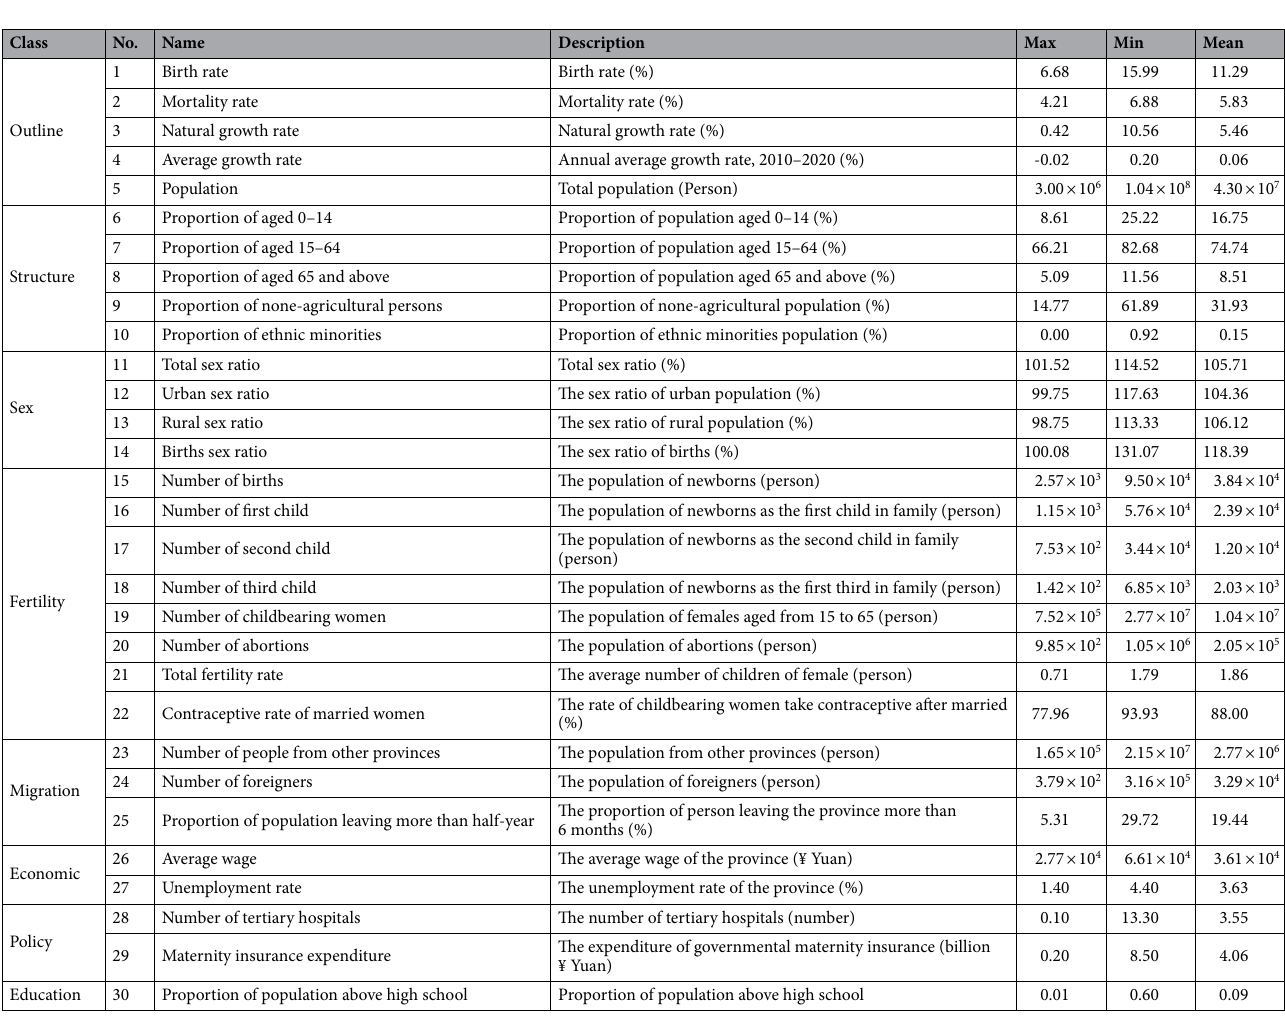
Table 2. Description of the demographic and socioeconomic factors (N = 31 (province), year =